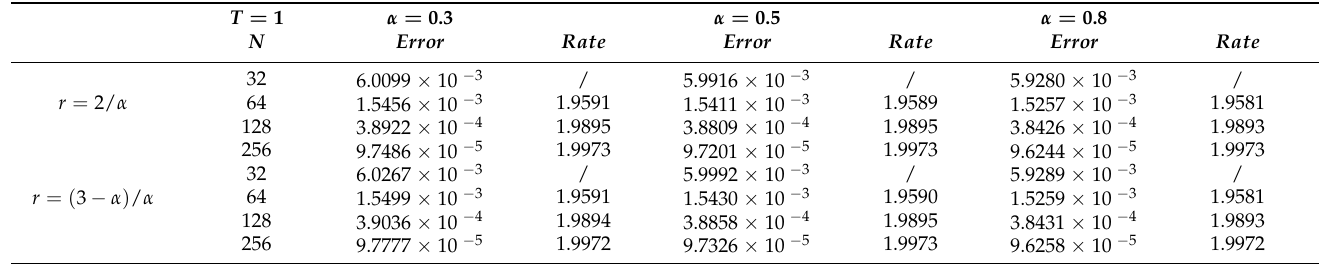
Table 7. Temporal numerical results of (cid:107) u n − U n (cid:107) on graded meshes to Example 2.